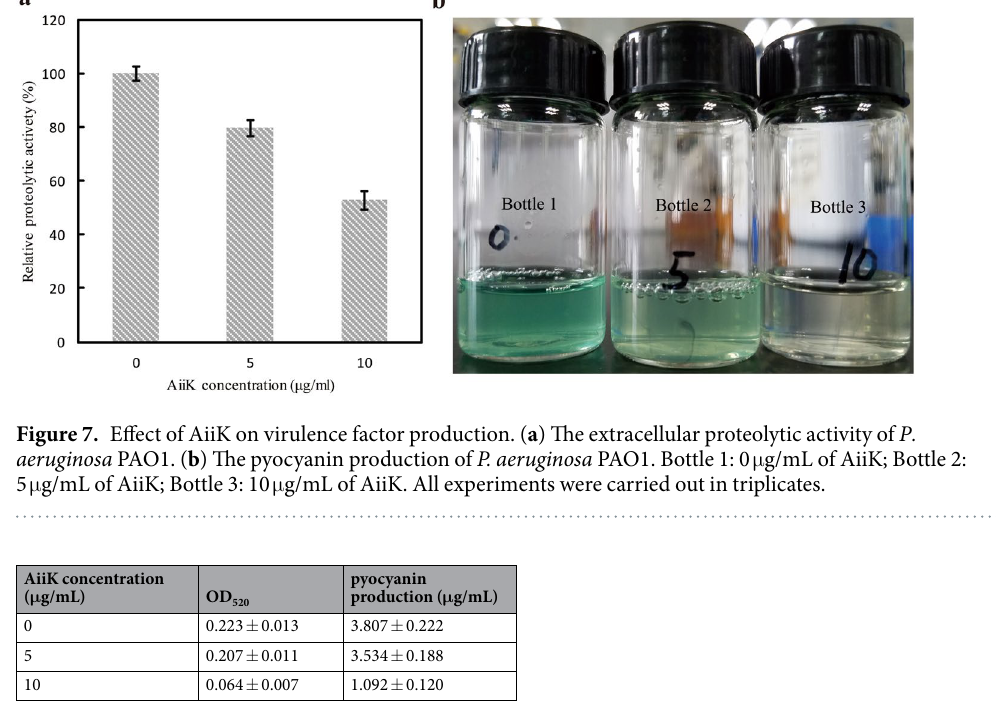
Table 2. Effect of AiiK on pyocyanin production in P. aeruginosa